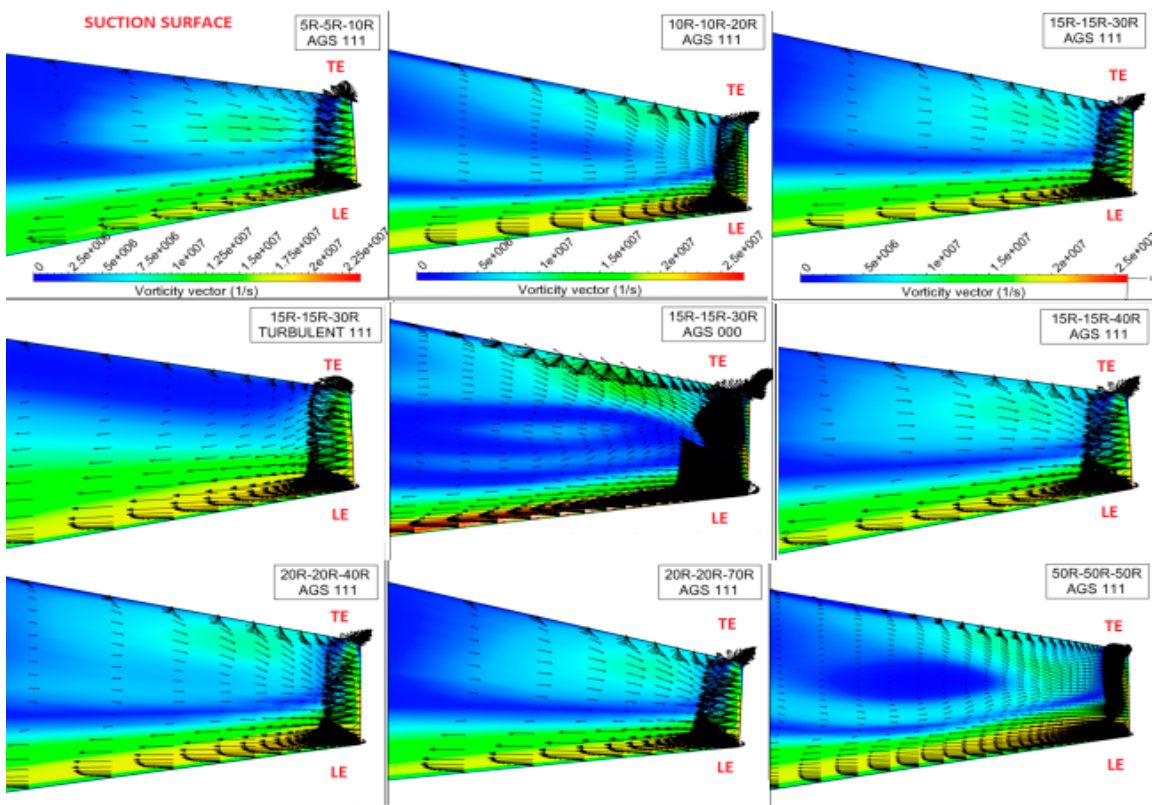
Figure 32. Vorticity vectors on skin friction contour for top 15% in various domains and transition models analyzed.